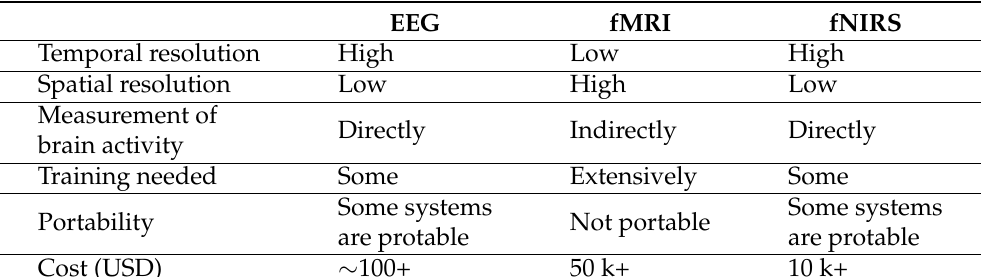
Table 1. A comparison between relevant brain imaging technologies that allow functional analysis of brain mechanisms.